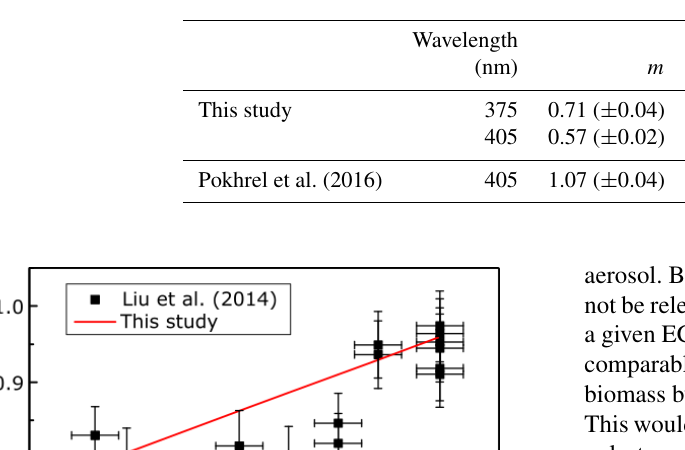
Table 2. ODR regression coefficients along with errors (in brackets) for plots of SSA vs. OC / TC ratios ( y = m (OC / TC) + c ) for the different biomass fuels used in this study, and parameters for ODR fit from Pokhrel et al. (2016) for 405nm, along with RMSE values for our fits.